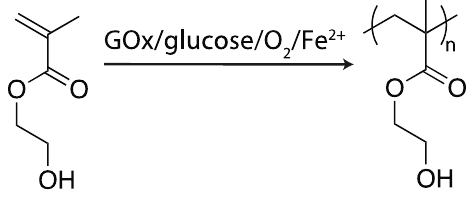
Figure 5. 2-Hydroxyethyl methacrylate (HEMA) is polymerized into poly(HEMA) in the presence of glucose oxidase (GOx), glucose, oxygen, and Fe 2+ [41].